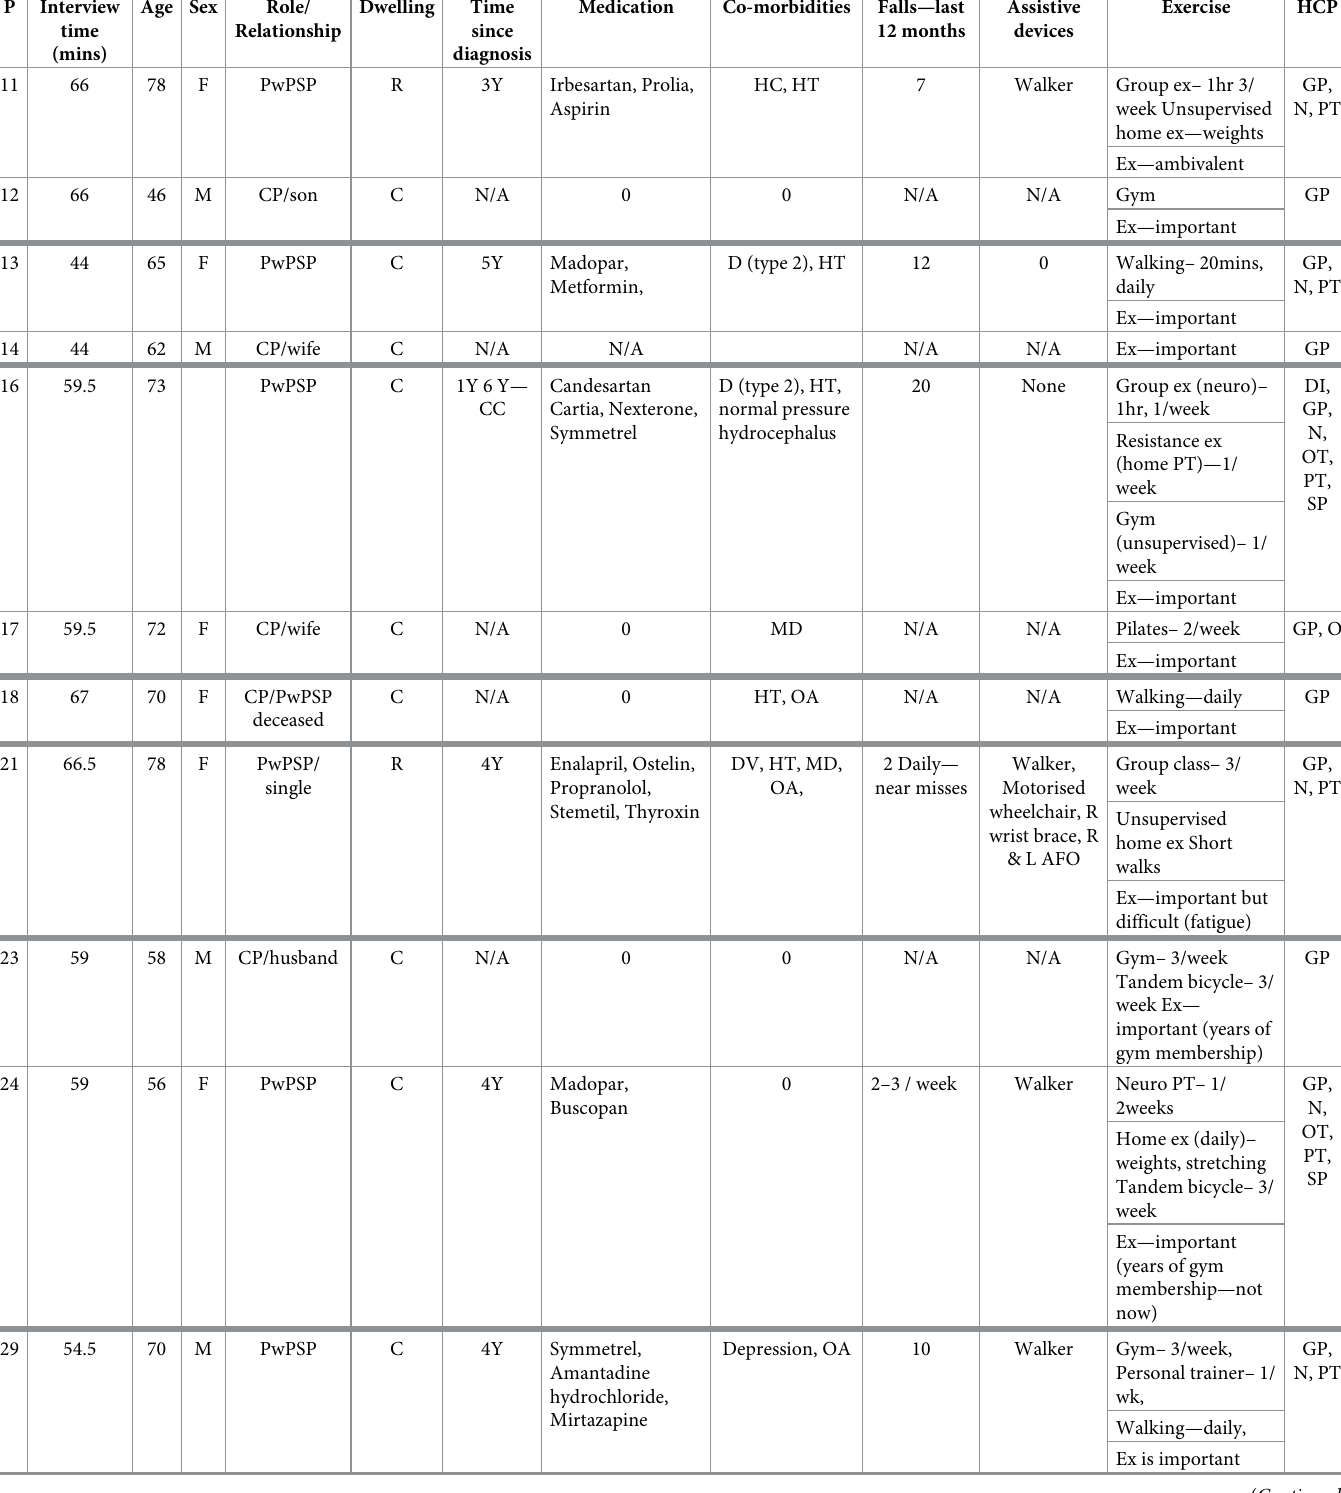
Table 2. Participant demographic